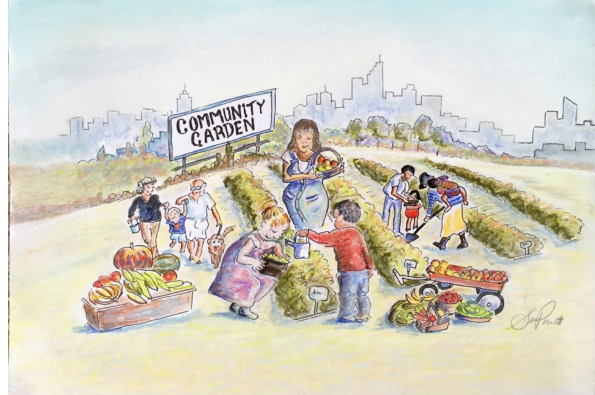
Figure 5. Community Gardens: Participation in personal, community and academic gardening programs has multiple social, personal and economic benefits. It increases nature-connectedness including the health benefits of microbial biodiversity, social and community cohesion, and positive emotions. It promotes a positive mental outlook and healthier behavior in general, including increased physical activity, increased intake of fruits and vegetables, and reduced fast-food consumption.